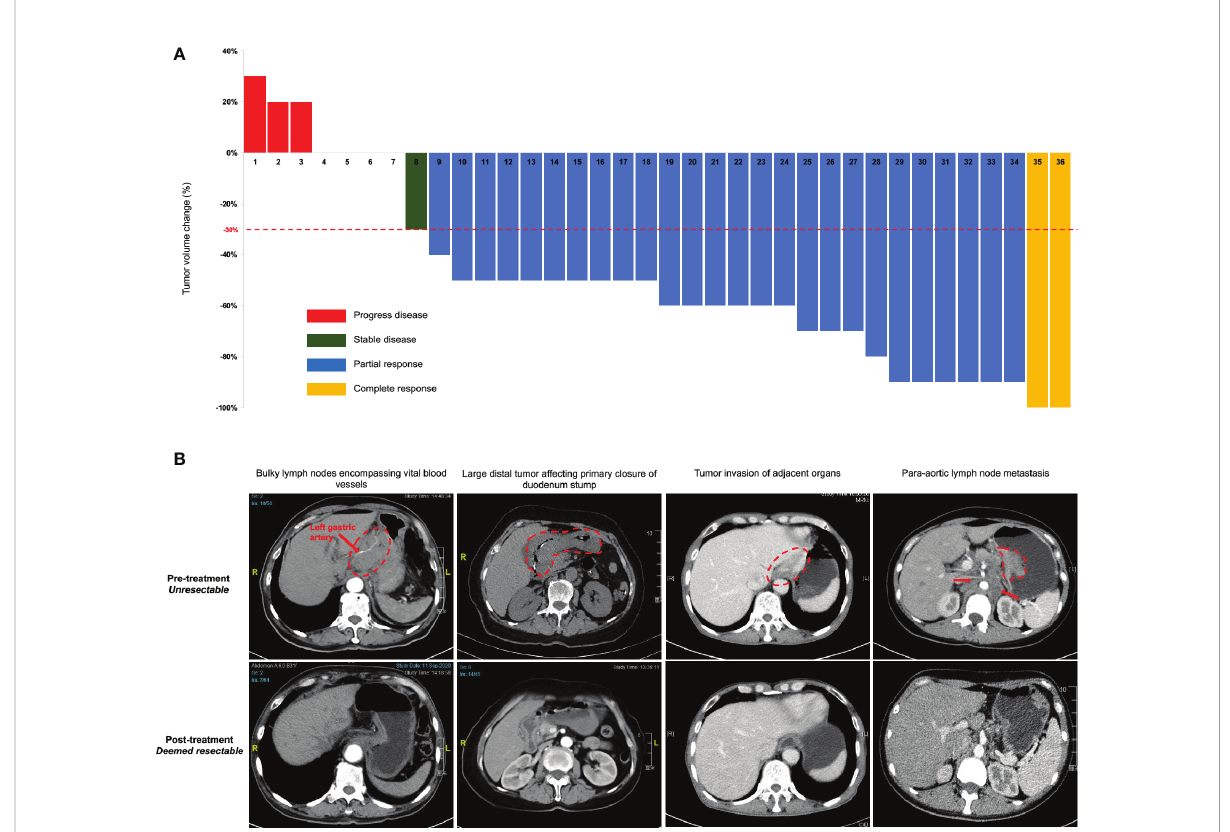
FIGURE 2 Clinical response to intra-arterial chemotherapy with sequential anti-PD-1 antibody. (A) Tumor volume changes from the baseline per Response Evaluation Criteria in Solid Tumors (RECIST) guidelines (version 1.1) in all enrolled 36 patients after the last induction treatment. (B) Representative computed tomography images illustrate several pre-treatment unresectable conditions and post-treatment improvement. The red dash circle and arrows indicate corresponding unresectable factors. Two images in the same column are from the same patient before and after the induction